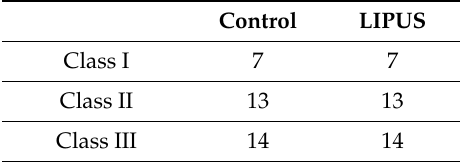
Table 1. The number of patients in each class of